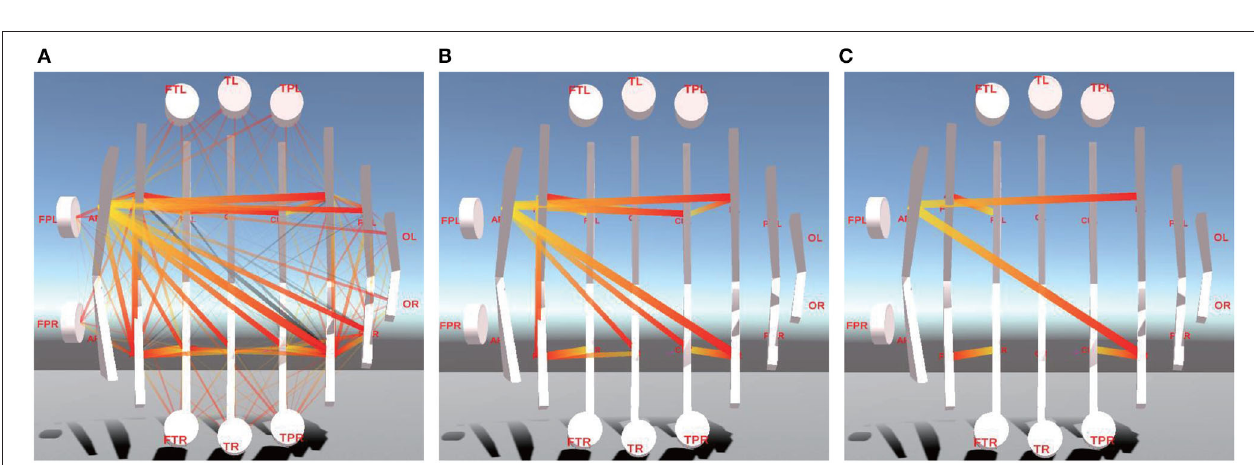
FIGURE 8 | This is between-L/RH FC visualization of different ranges of PCC. (A) is between-L/RH FC visualization of the whole PCC. (B) is between-L/RH FC visualization of 1/2 of PCC. (C) is between-L/RH FC visualization of 1/8 of PCC.